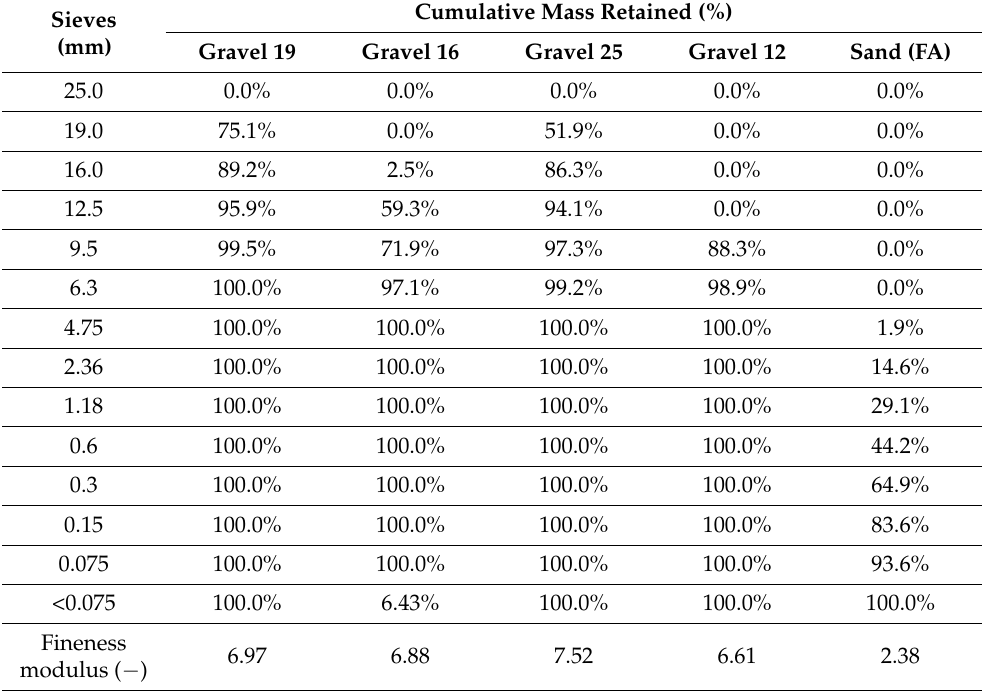
Table 2. Granulometric distribution of the aggregates